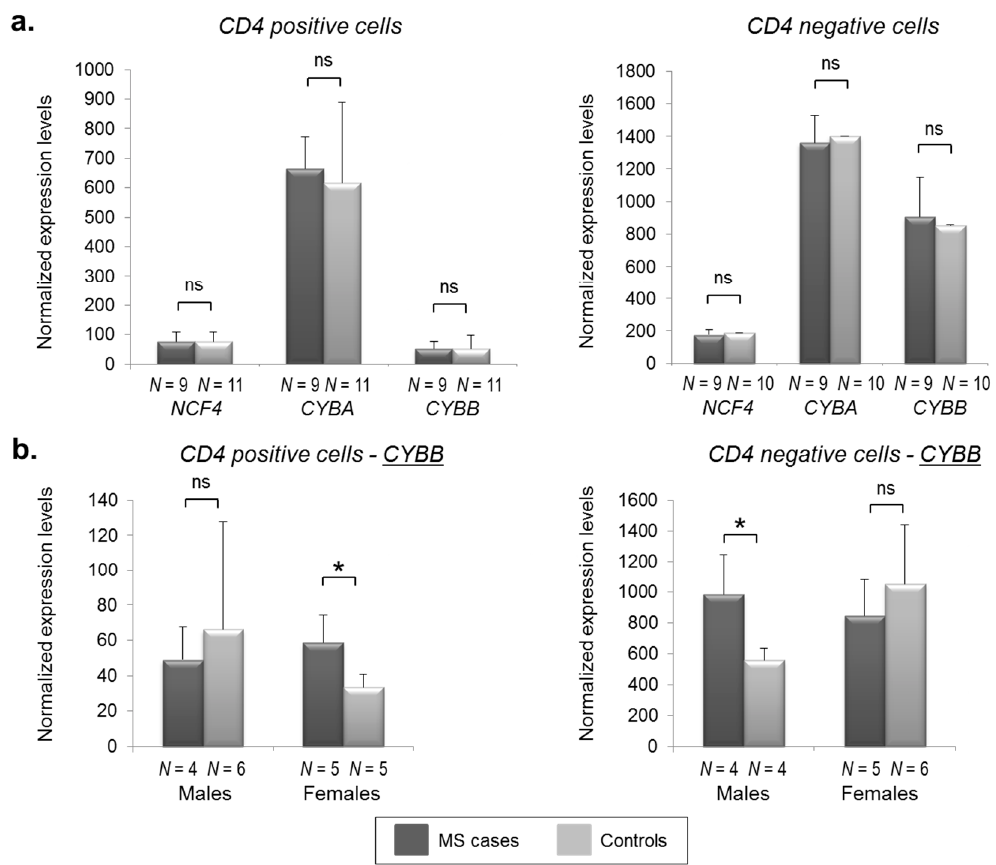
Figure 2. CYBB shows sex-related and cell-specific differential expression in MS cases and controls. NCF4 , CYBA , and CYBB expression levels (shown by histograms) were measured by means of microarray-based experiments (see the “Materials and Methods” section). The number of subjects belonging to each group is indicated ( N ). Error bars represent means + SD (standard deviation). Significance levels of t -tests are shown. *: p < 0.05.